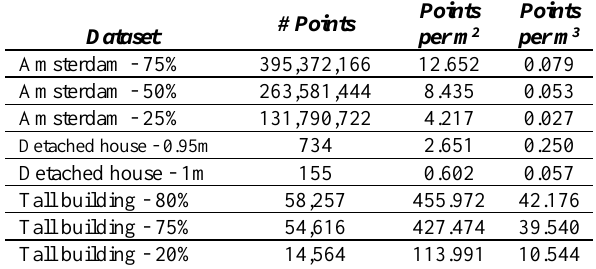
Table 4. Details of the created subsampled